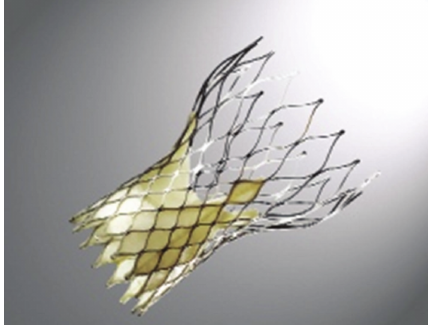
Figure 2: The CoreValve self-expandable prosthetic valve, con- structed of a nitinol stent, pericardial leaflets, and sealing cu ff